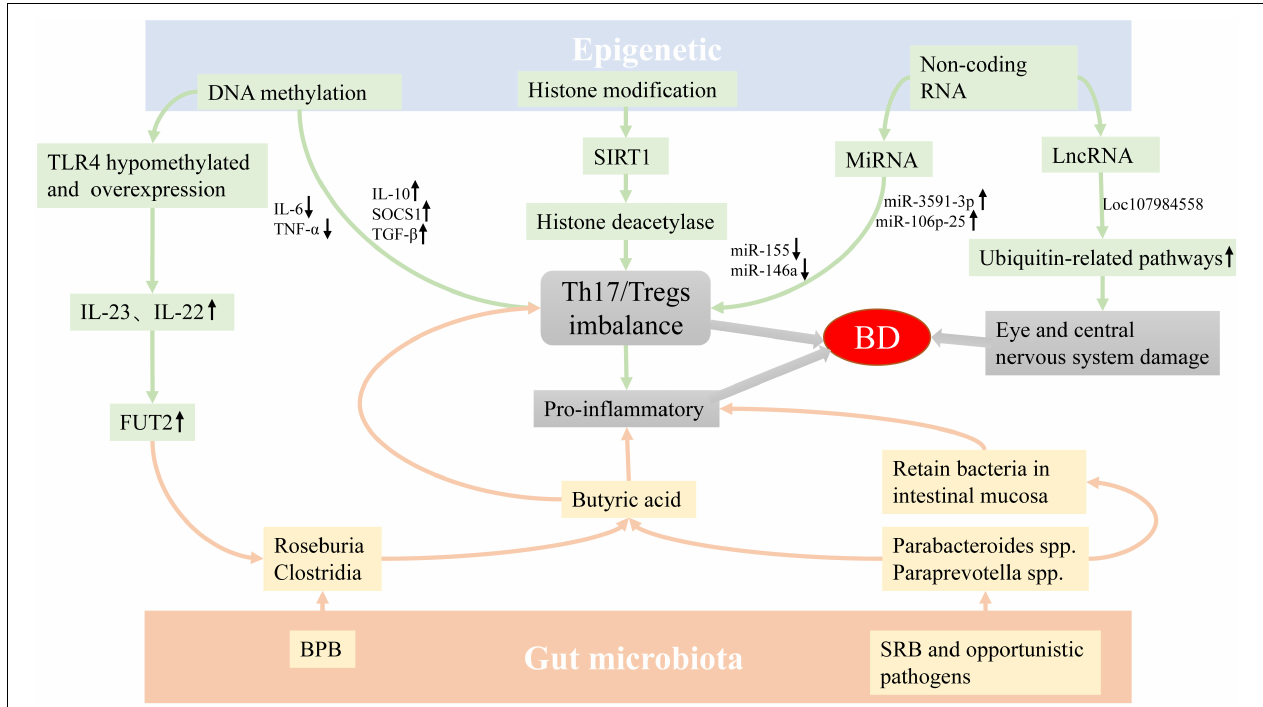
FIGURE 1 | The possible mechanism of epigenetics factors and GM involving the pathogenesis of BD. The imbalance of GM and epigenetics abnormality may be involved in the occurrence of BD by regulating the differentiation of T cells. In addition, the abnormality of conditional pathogenic bacteria may cause inflammation by retaining bacteria in intestinal mucosa, and the abnormality of LncRNA can also cause eye and central nervous system damage in patients with BD. Abbreviation: GM: Gut microbiota, BD: Behçet’s disease, BPB: butyrate-producing bacteria, SRB: sulfate-reducing bacteria.